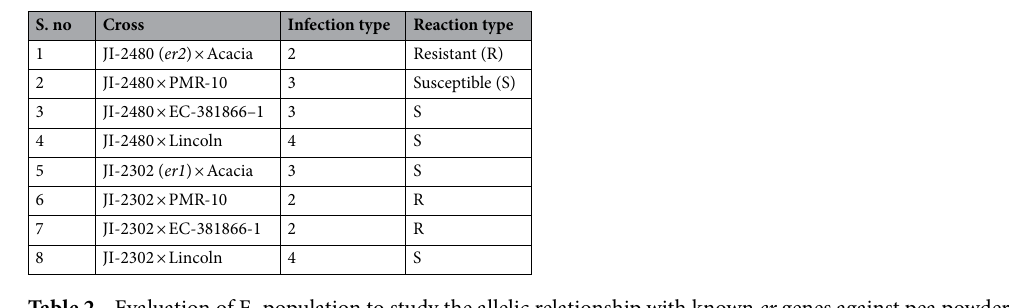
Table 2. Evaluation of F 1 population to study the allelic relationship with known er genes against pea powdery mildew caused by Erysiphe pisi.